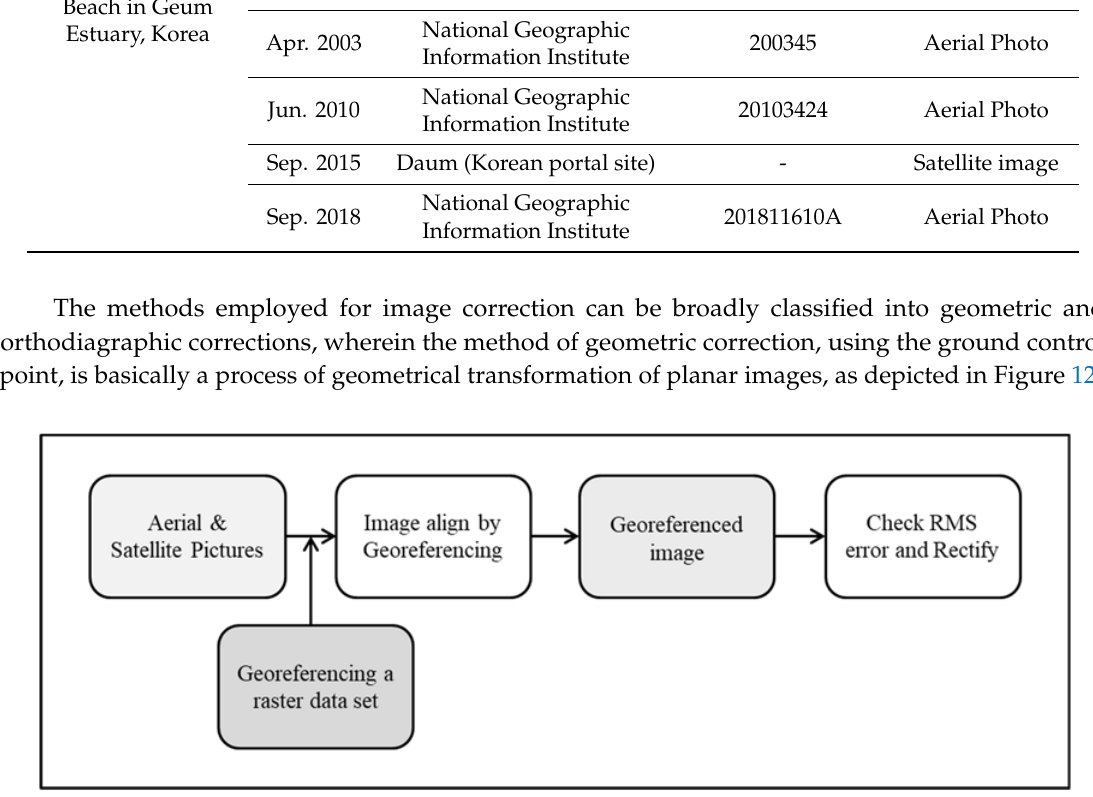
Figure 14. Aerial photograph of georeferenced Janghang Beach. 4.3. Estimation of Coastal Sediment Loss Rate(K) The area of the Janghang Songrim Beach, Seocheon County, Chungcheongnam ‐ do Province in the photograph captured in 1947 shows an intact, wide sandy beach. The corrected photograph captured in 1985 is considered to be the beach before the construction of the Geum estuary barrier, which was completed in 1990, and thus the shorelines from the years 1985, 2000, 2003, 2010, 2015, and 2018 were extracted to examine the changes that occurred in the width and area of the beach. During the period of 1947 to 2018, the baselines were set using a spacing of 100 m on the Janghang Songrim Beach (Figure 15), and the changes in baseline, area, and width of the beach in each sector, are shown in Table 7. By examining the changes that occurred in the width of Janghang Songrim Beach, a gradual progression of beach erosion was found. In particular, with respect to the changes in width of the beach during the period of 1985 to 2000, approximately 14 m of erosion occurred. Approximately 27% of the erosion occurred in 1985, when the average width of the beach was approximately 52 m. In terms of the total beach area, a serious long ‐ term beach erosion also appeared (Table 7).